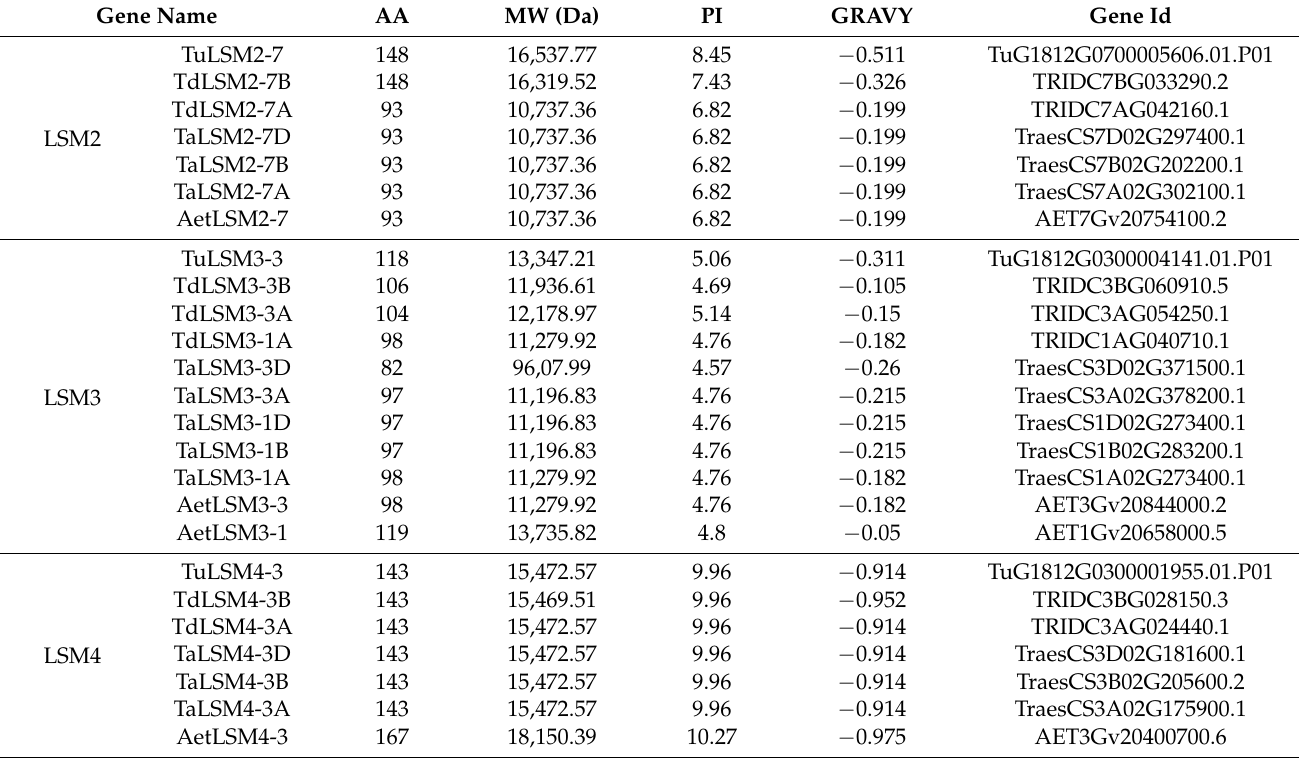
Table 1. The physico-chemical properties features of Smith (SM)/SM-Like (SSM/SLSM)